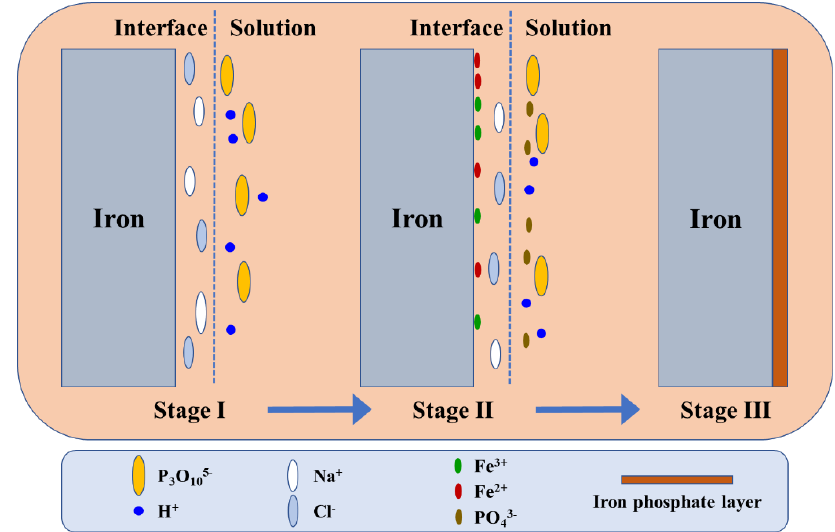
Figure 9. Proposed mechanism of ATP-6-AHA on S235 steel surface.